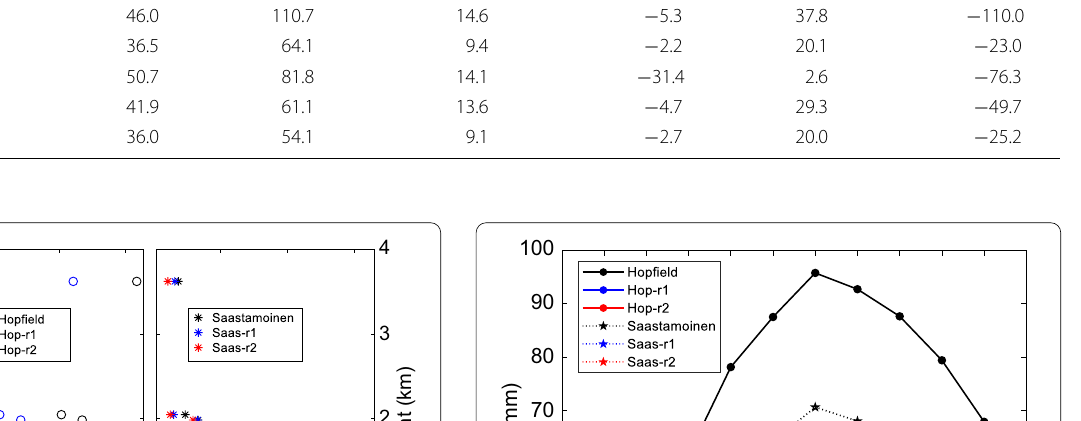
Table 1 Mean RMSE and bias of the ZTD differences for the six models at all stations Names of the model Results of RMSE (mm) Results of bias (mm) Mean Maximum Minimum Mean Maximum Minimum Hopfield 70.5